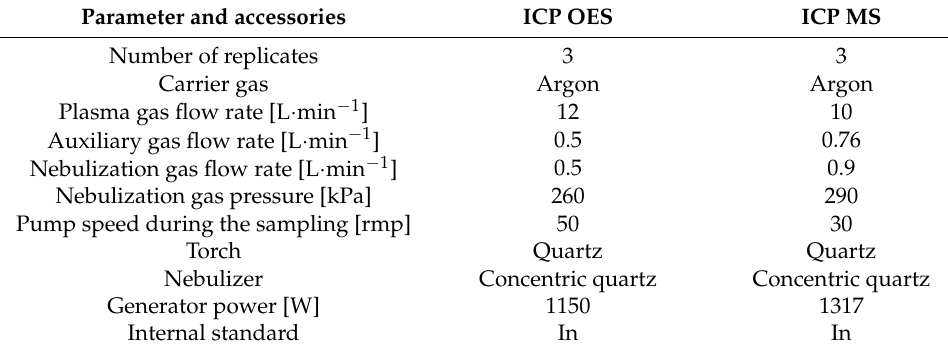
Table 11. ICP-OES (Thermo Scientific, ICAP 7400 series, Waltham, MA, USA), ICP-MS (Thermo Electron Corporation, X SERIES, Rugby, UK) parameters and measurement conditions.